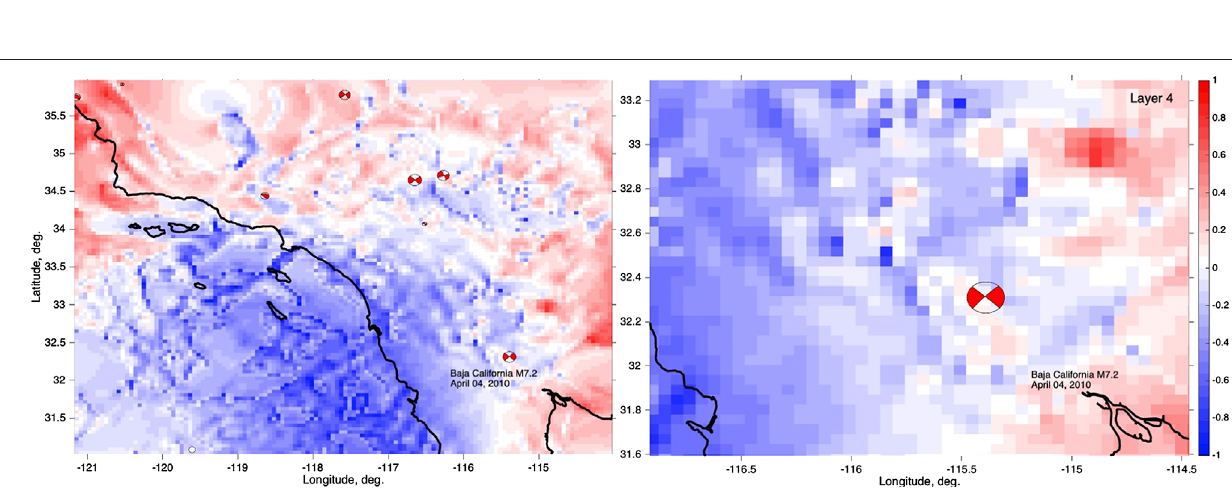
FIGURE9| Lode – Nadaicoef fi cientmapsinlayer4asofApril1,2010,beforethe M 7.2BajaCaliforniaearthquakefortheentirestudyarea(leftpanel)andepicentral region (right panel). Reddish color indicates compression, bluish — extension, and whitish — shear stress